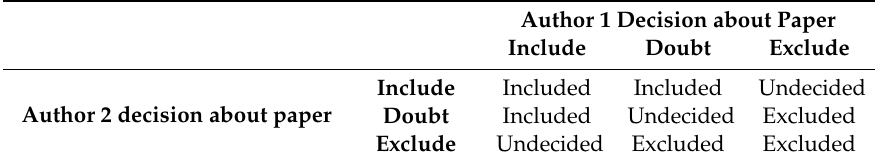
Table 2. Decision matrix.